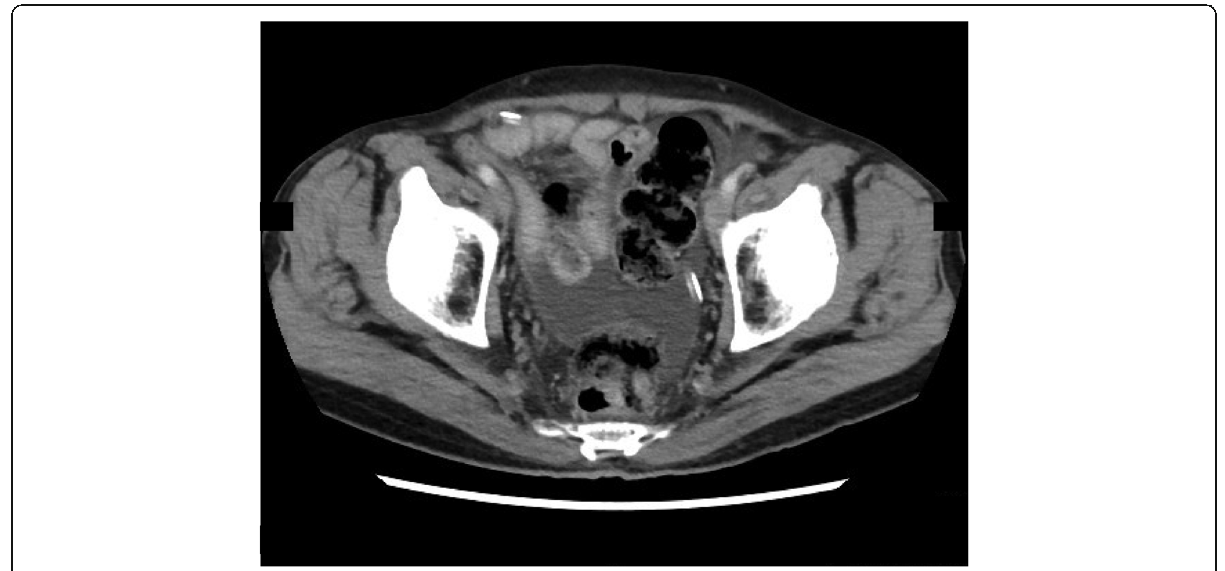
Fig. 3 Contrast-enhanced computed tomography image after combination chemotherapy showing decreased ascites in the pelvic